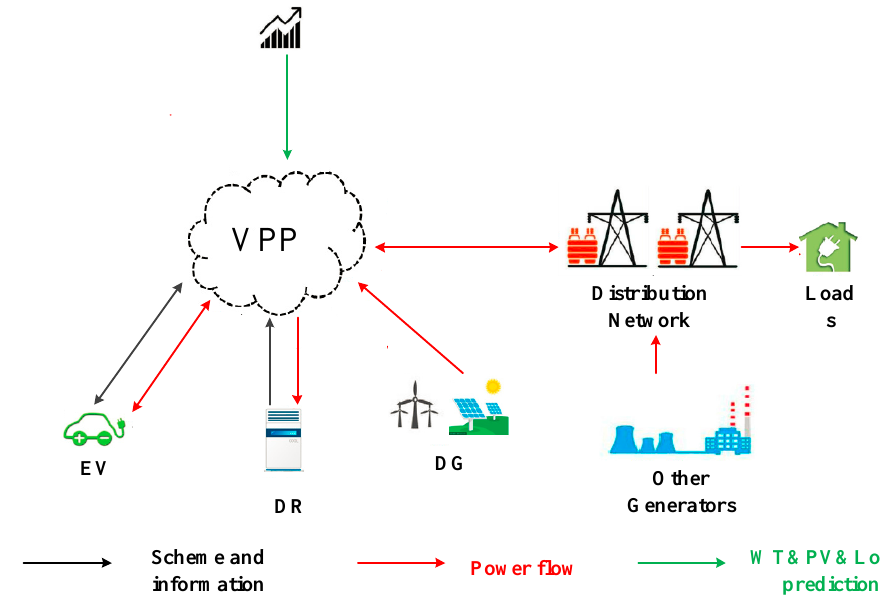
Figure 1. The illustration of the constitution of virtual power plant.